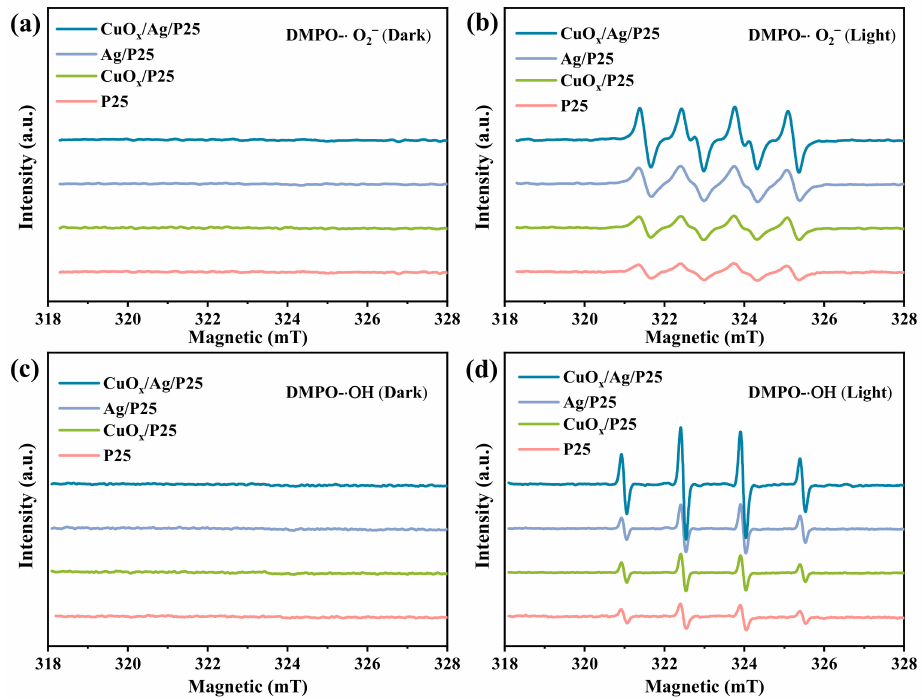
Figure 4. EPR spin-trapping spectra of DMPO −• O 2 − and DMPO −• OH adducts ( a , c ) in the dark and ( b , d ) under illumination, respectively, for P25, CuO x /P25, Ag/P25, and CuO x /Ag/P25. The light used was full-spectrum